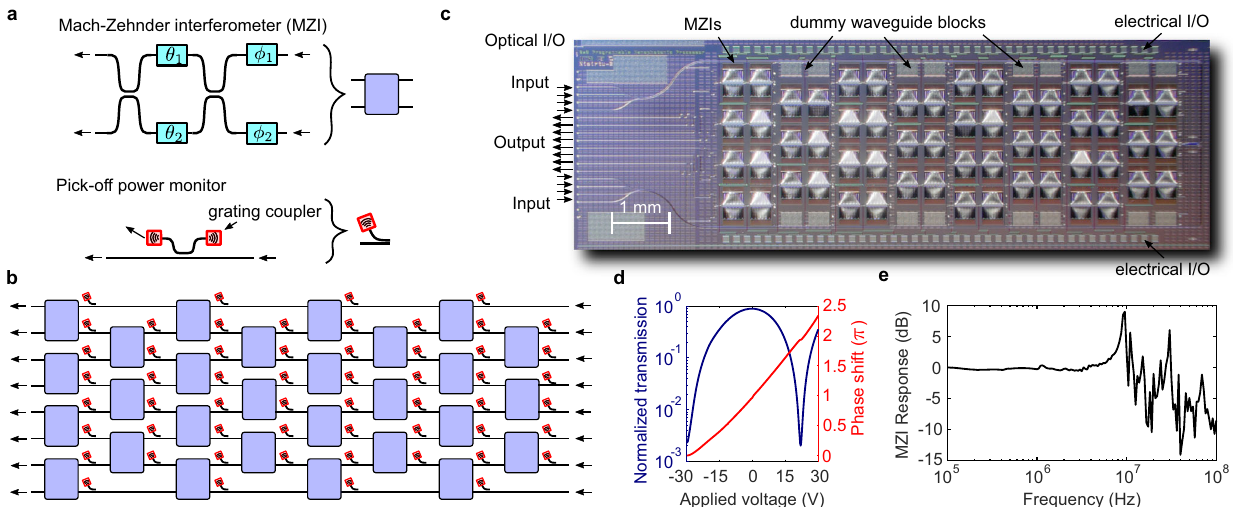
Fig. 2 8-channel programmable photonic Mach – Zehnder mesh. a Schematic of the basic building blocks of the photonic integrated mesh: a Mach – Zehnder interferometer (MZI), consisting of four optical phase-shifters and the on-chip power monitoring element, consisting of a pick- off beam splitter and grating couplers. b Full diagram of the 8 × 8 programmable Mach – Zehnder mesh. c Optical microscope image of the fully fabricated photonic circuit with optical and electrical I/O labeled. d DC response when actuating phase shifts θ 1 - θ 2 in a single Mach – Zehnder element, showing a V π ~25 V. e AC response when actuating phase shifts θ 1 - θ 2 in a single Mach – Zehnder element, showing a relatively fl at frequency response until a peak mechanical resonance at ~10